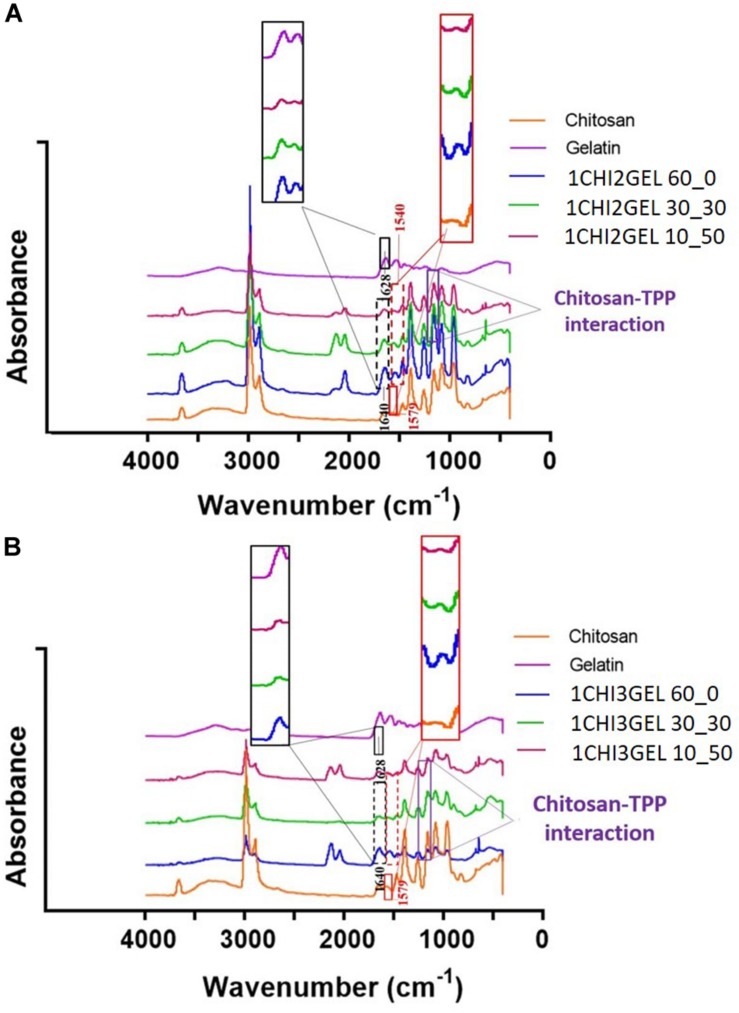
FTIR characterization of 3D printed chitosan- gelatin scaffolds. (A) FT-IR spectra of both pure chitosan and gelatin material, and different crosslinking conditions for 1CHI2GEL. The black and red boxes report a magnification of the shifts in the blends spectra, compared to the pristine material spectra. (B) FT-IR spectra of both pure chitosan and gelatin material, and different crosslinking conditions for 1CHI3GEL.